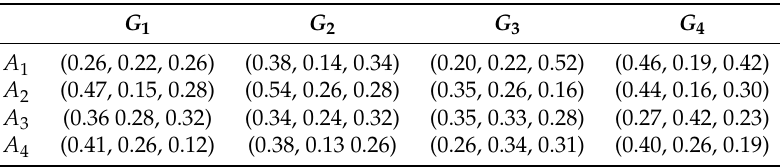
Table 2. The aggregated decision matrix given by four decision